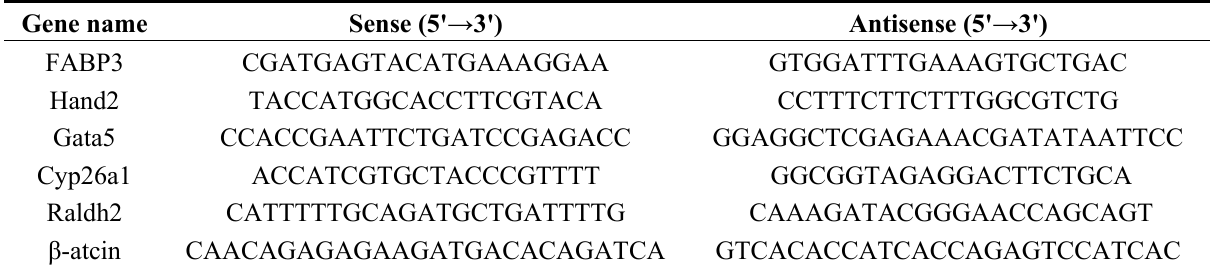
Table 2. Sequences for primer sets used in qPCR gene expression